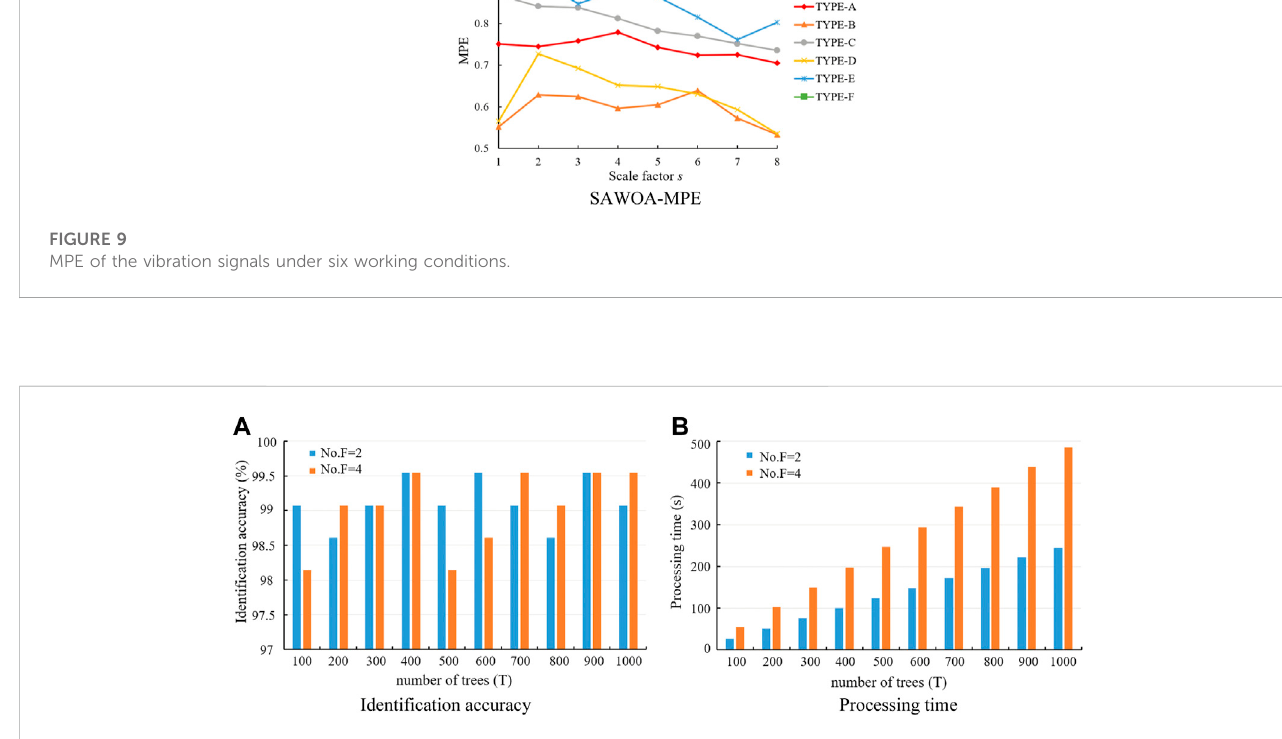
FIGURE 10 Identi fi cation accuracy and processing time of diagnosis model.